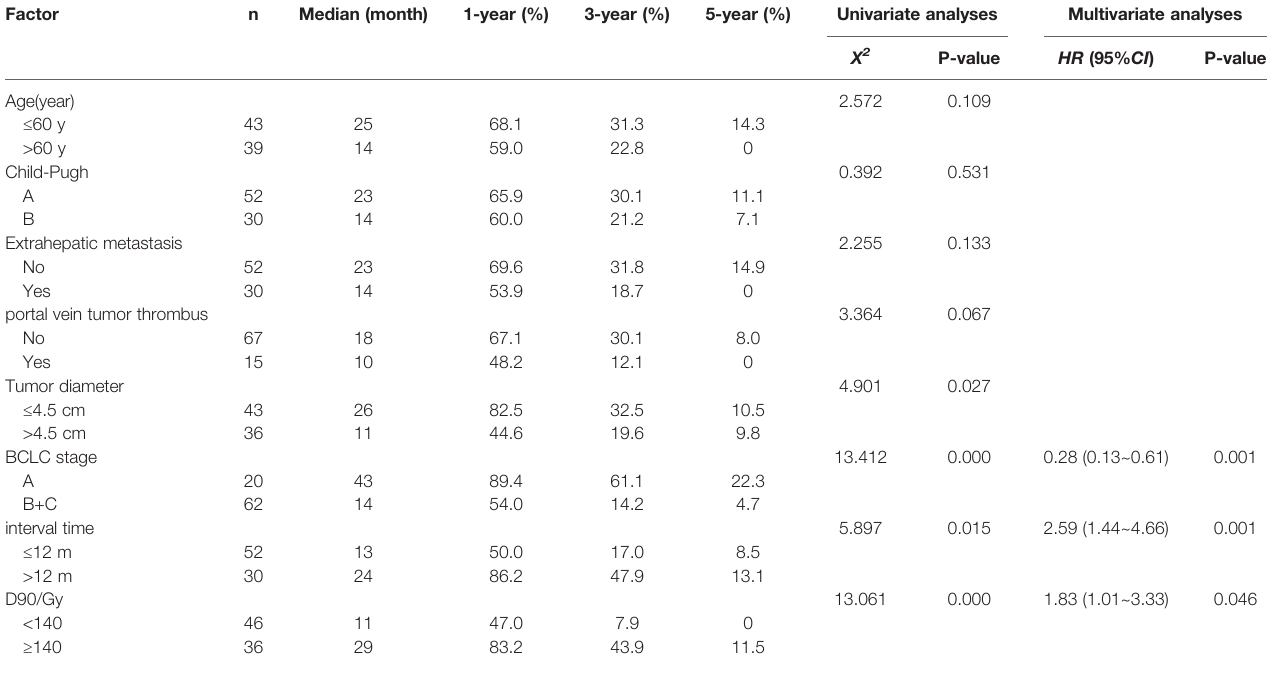
TABLE 3 | Univariate and multivariate analyses of factors in fl uencing local progression-free survival.